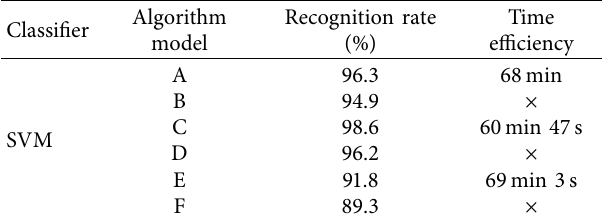
Table 5: Recognition rate and time efficiency of different algorithm models under SVM classifier.